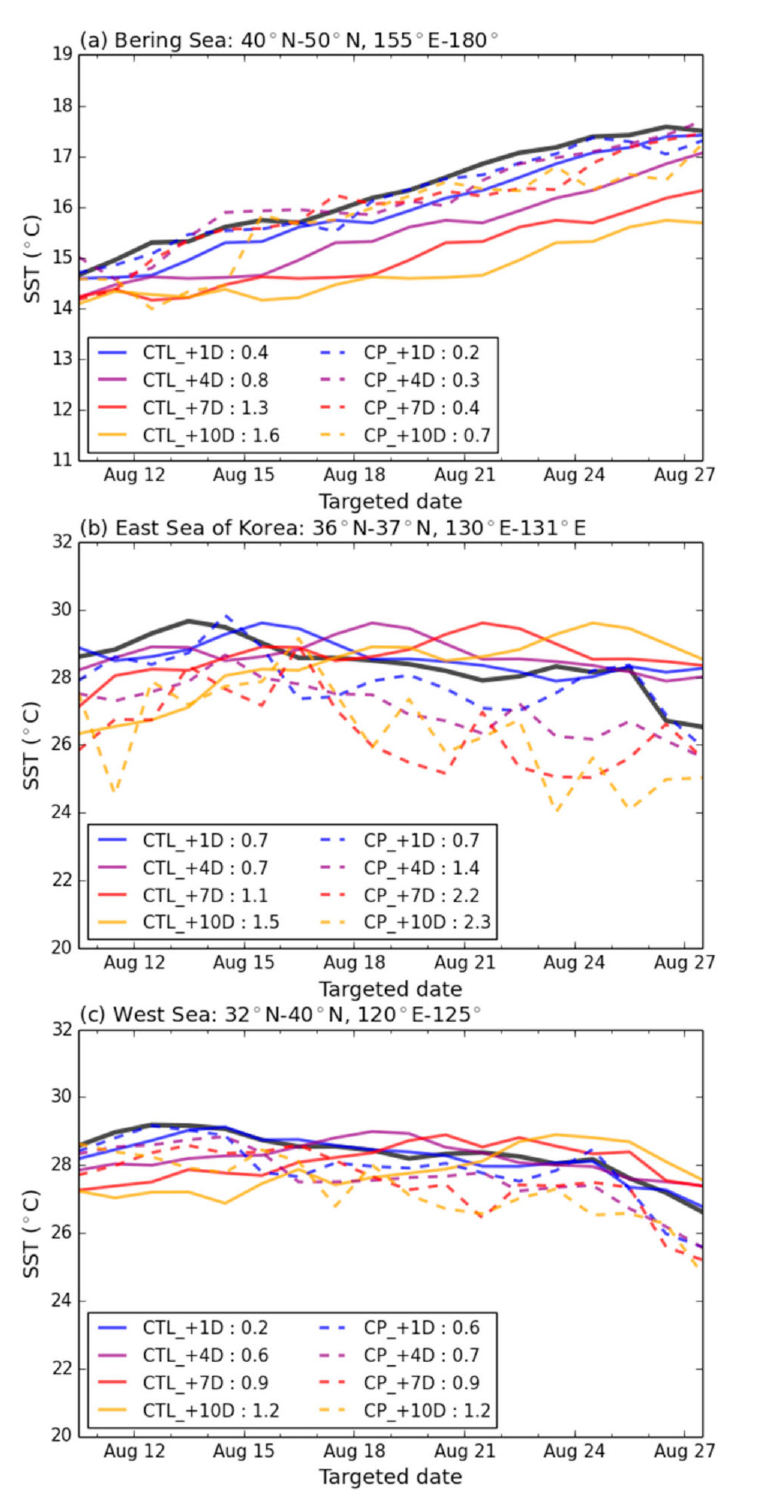
Figure 11. Same as Figure 6, but for daily SST ( ◦ C) averaged over ( a ) Bering Sea (40 ◦ N–50 ◦ N, 155 ◦ E–180 ◦ E) ( b ) East Sea (32 ◦ N–40 ◦ N, 120 ◦ E–135 ◦ E) and ( c ) West Sea of Korea (32 ◦ N–40 ◦ N, 120 ◦ E–125 ◦ E). The black line represents OSTIA analysis and RMSEs are calculated using OSTIA. The reason of the shift at the 1-day forecast in the CTL experiment is that the CTL experiment uses the previous day’s SST